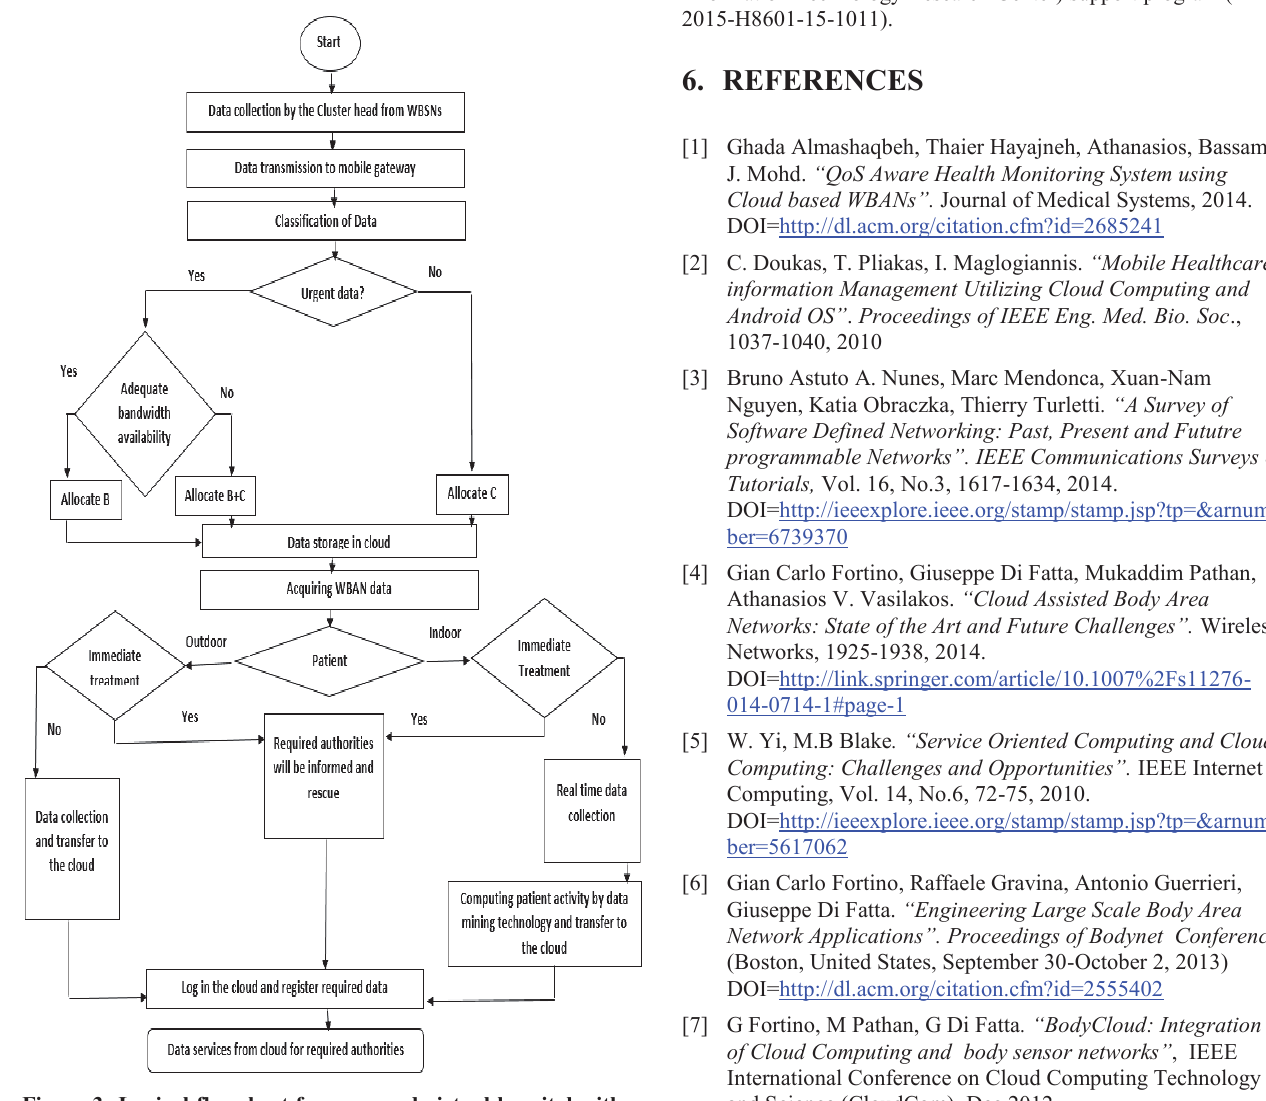
Figure 3: Logical flowchart for proposed virtual hospital with the integration of SDN based